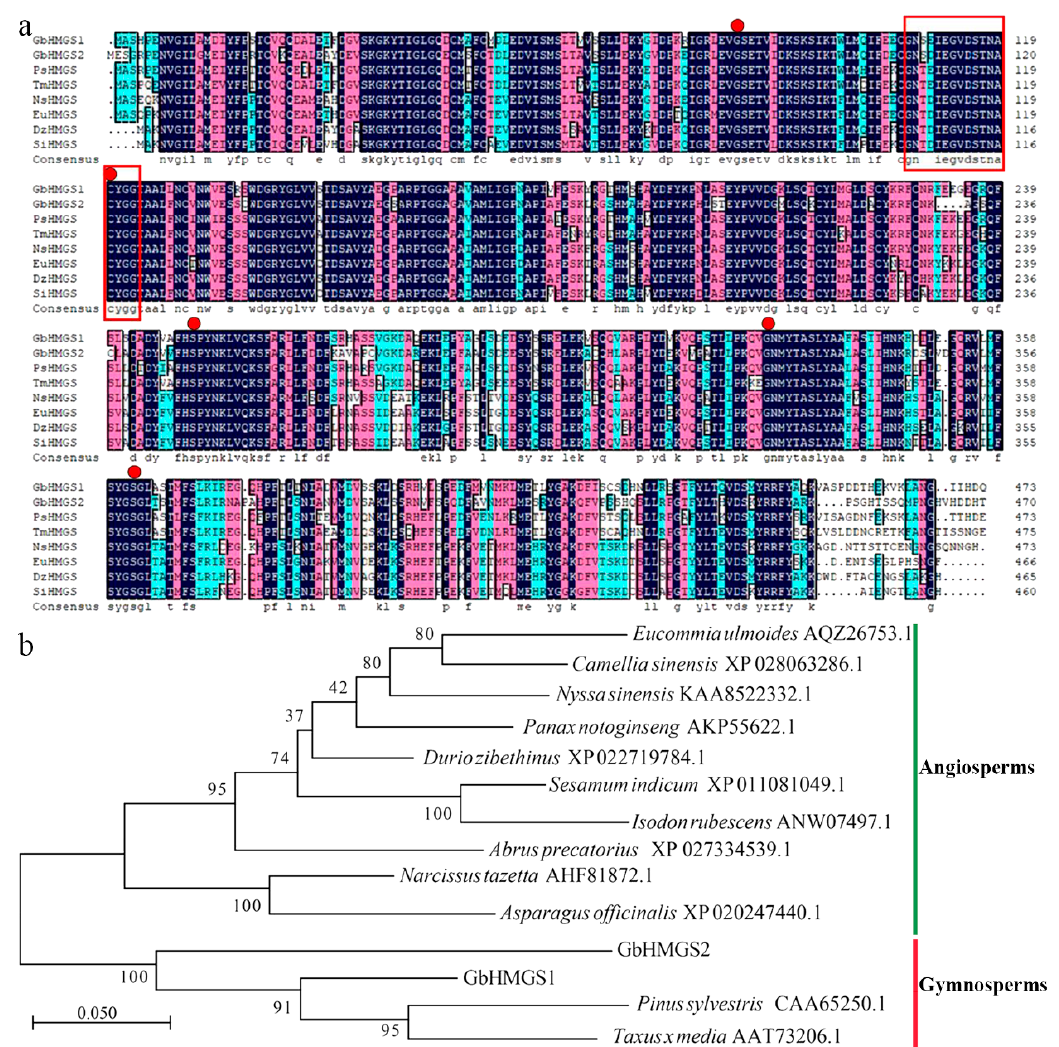
Figure 2. Sequence and phylogenetic analysis of GbHMGS1 and GbHMGS2. Comparison of GbHMGS1 and GbHMGS2 with other known HMGS amino acid sequences ( a ) and phylogenetic tree ( b ).